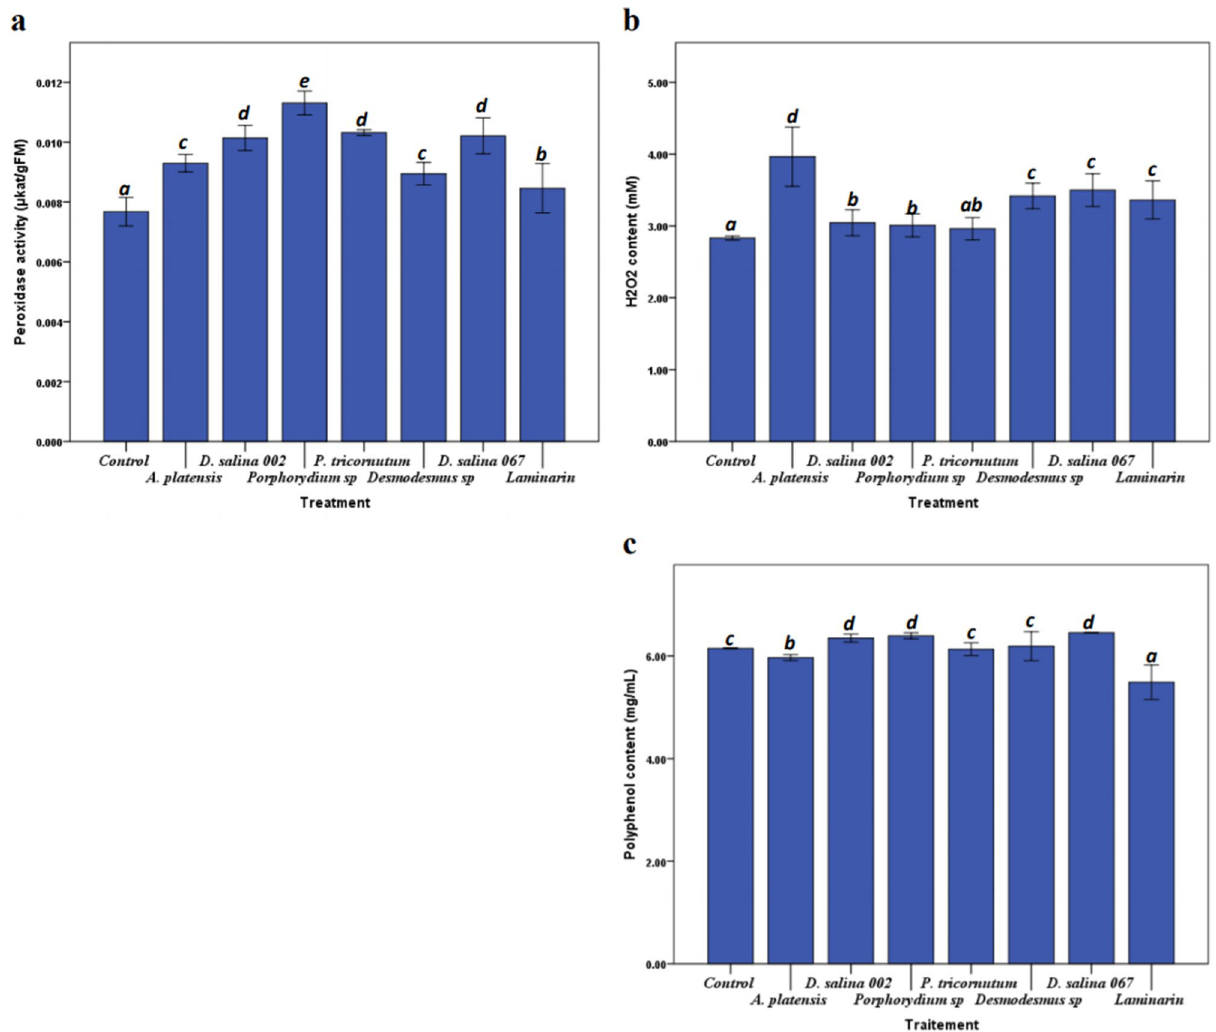
Figure 2. Peroxidase activity ( a ), H 2 O 2 ( b ) and polyphenols content ( c ) in the tomato plants leaves after Polysaccharide treatment. Tomato plants were injected with 1 mg mL −1 of PS, and H 2 O or Laminarin (1 mg mL −1 ) as a negative and positive controls respectively. Values are the mean (± SE) of five replicates. Different letters indicate significant difference between treatments ( p < 0.05) according to Turkey-test, One-way ANOVA.